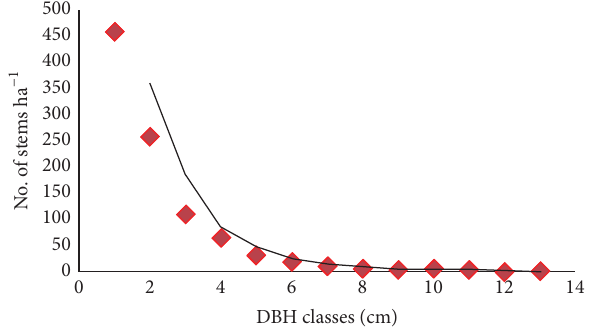
Figure 3: Size class distribution of mature forests showing a reverse J shape, the numbers represent the DBH classes in cm. 2 (10–15), 4 (20–25), 6 (30–35), 8 (40–45), 10 (50–55), 12 (60–65), and 14 ( ≥ 65).